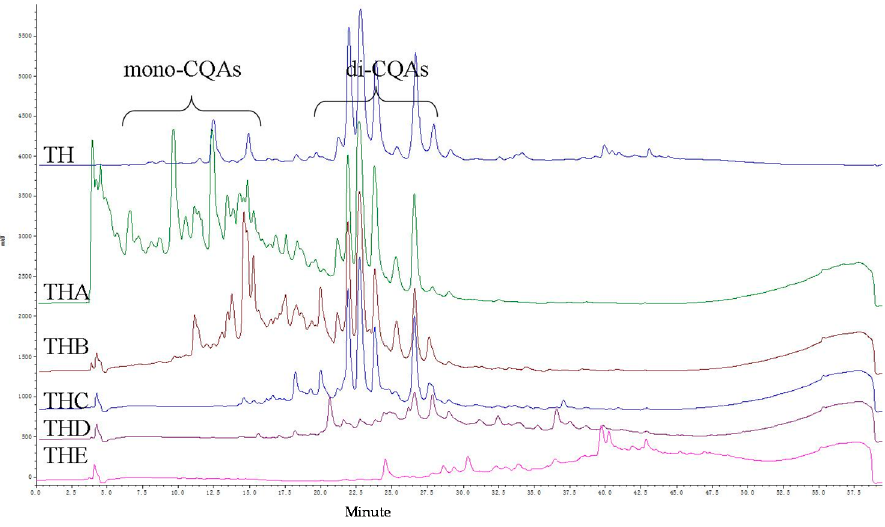
Figure 1. HPLC chromatogram of ethanol extract (TH) and MCI fractions (THA–THE) of Ch. coronarium L.